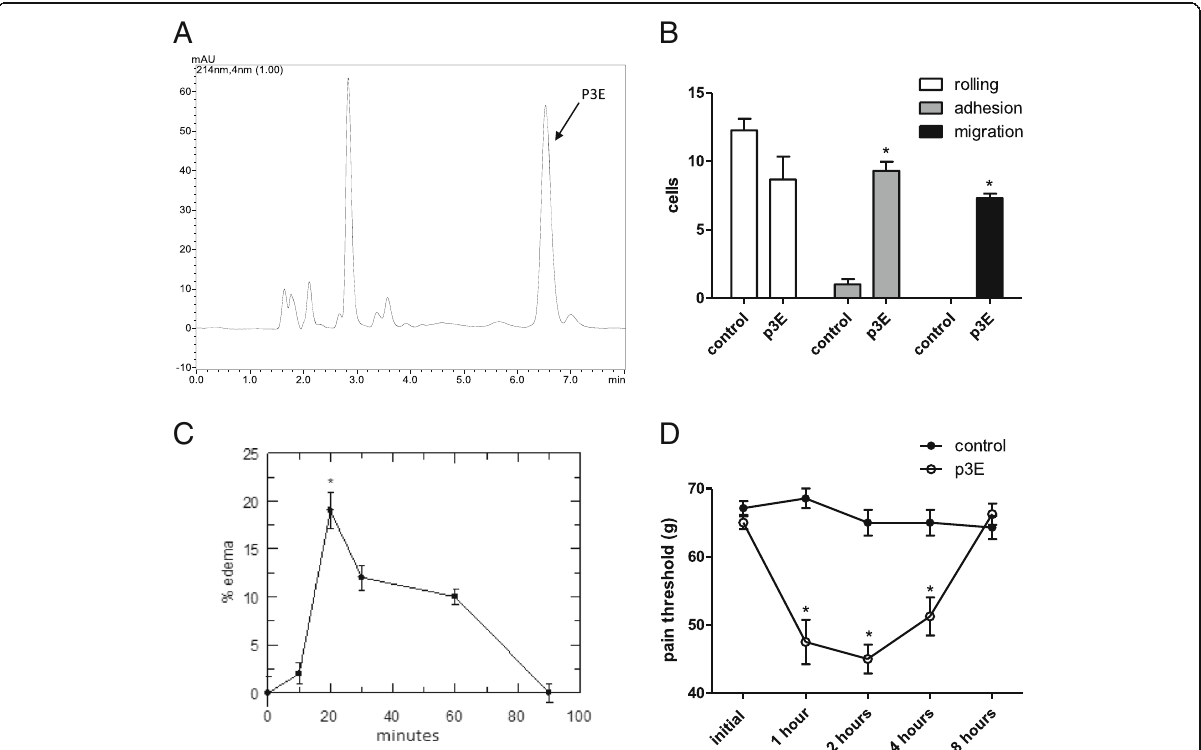
Fig. 3 Re-purification of p3 and its inflammatory effects. a RP-HPLC purification of p3, in a C18 carbon column, in an isocratic elution with 0.1% TFA in water. The arrow indicates the proinflammatory peak, named p3E. b Leukocyte count on the cremaster muscle microcirculation 2 h after p3E injection. c Paw edema percentage (control-related) after p3E injection. d Pain threshold evaluation after p3E injection. * p <